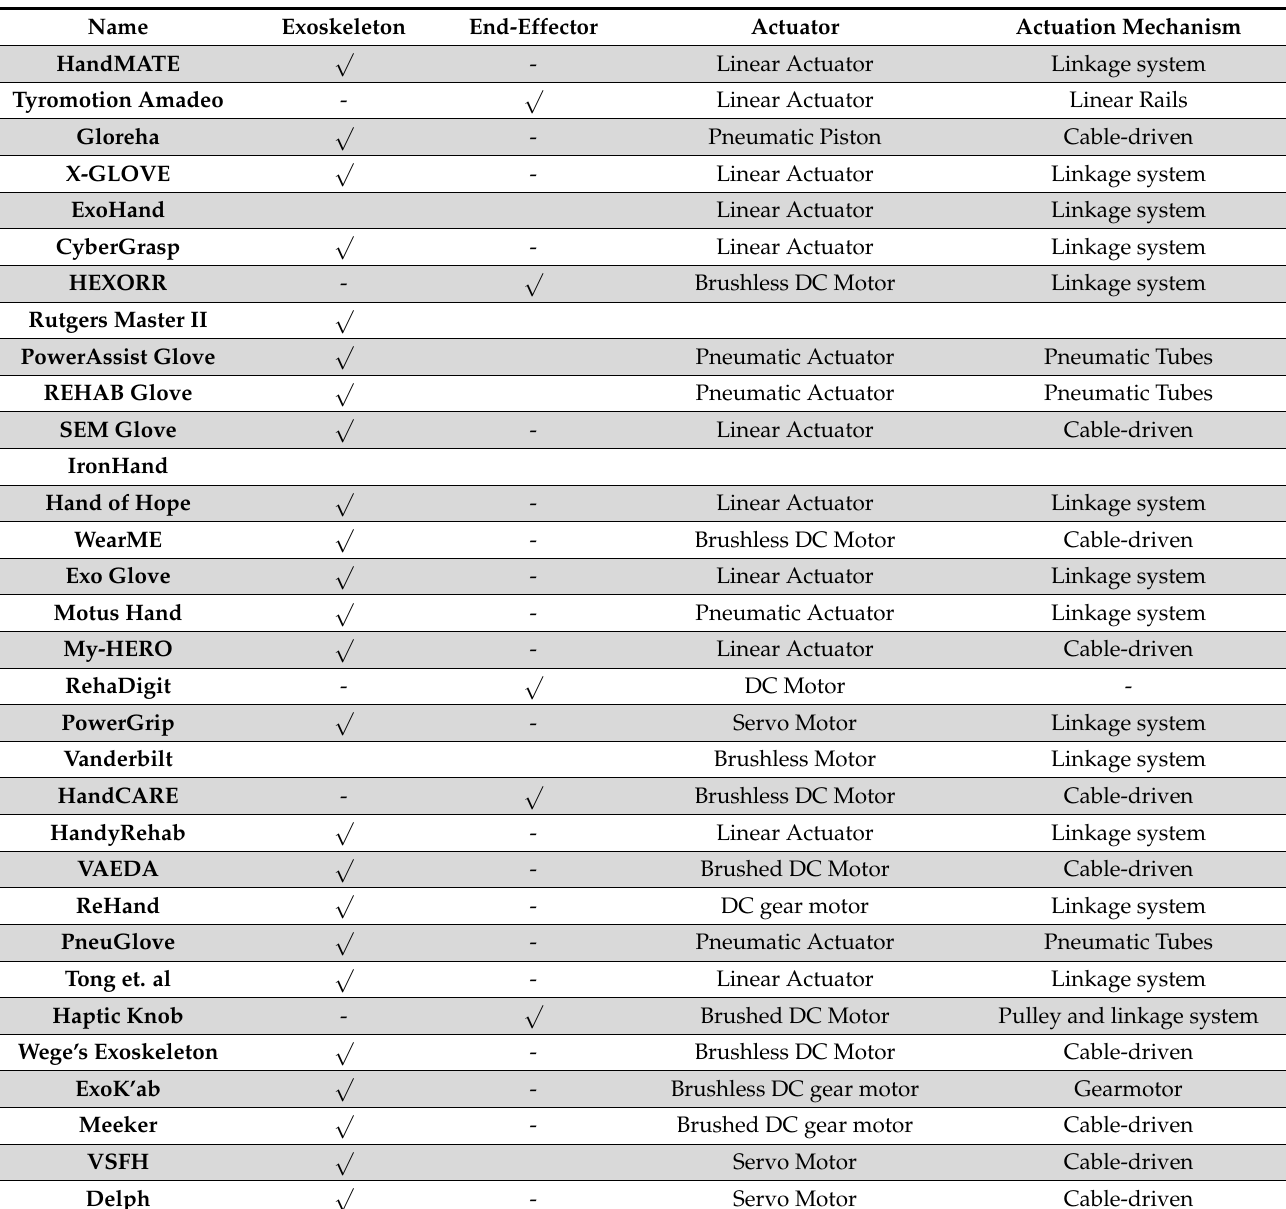
Table 7. Powered Devices classified into actuation